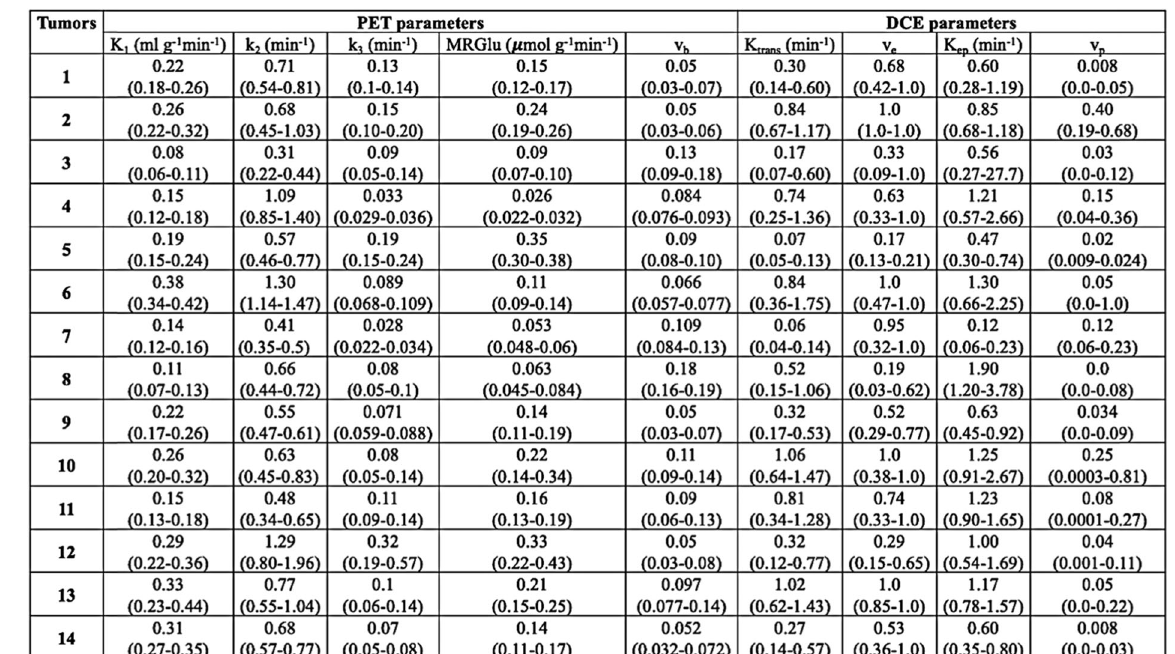
Table 2 Estimated PET and DCE kinetic parameters. Kinetic parameters are expressed as median